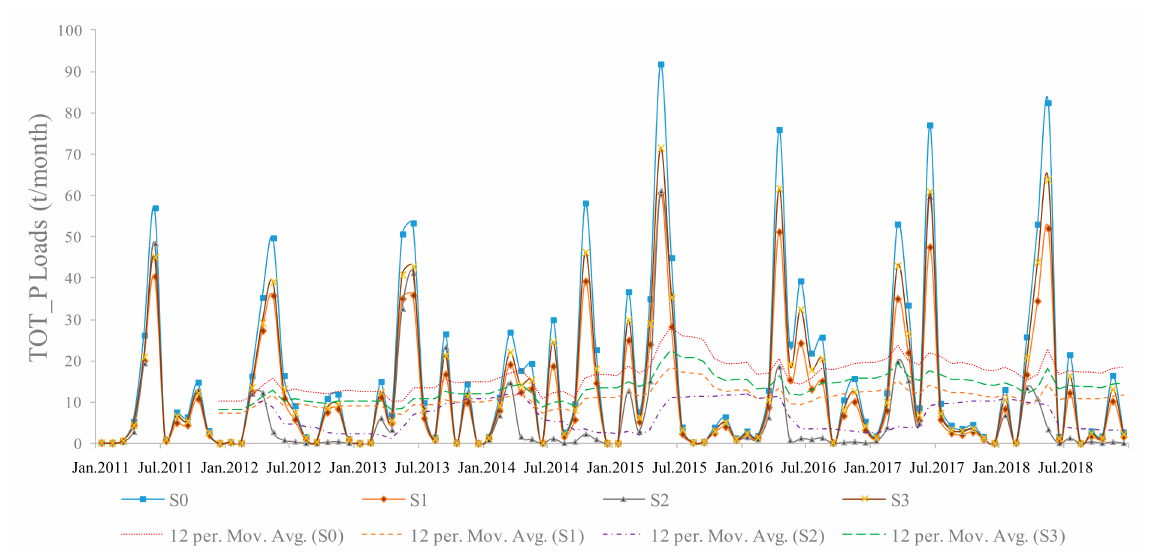
Figure A2. Simulation of monthly TOT_P load in MLW under different